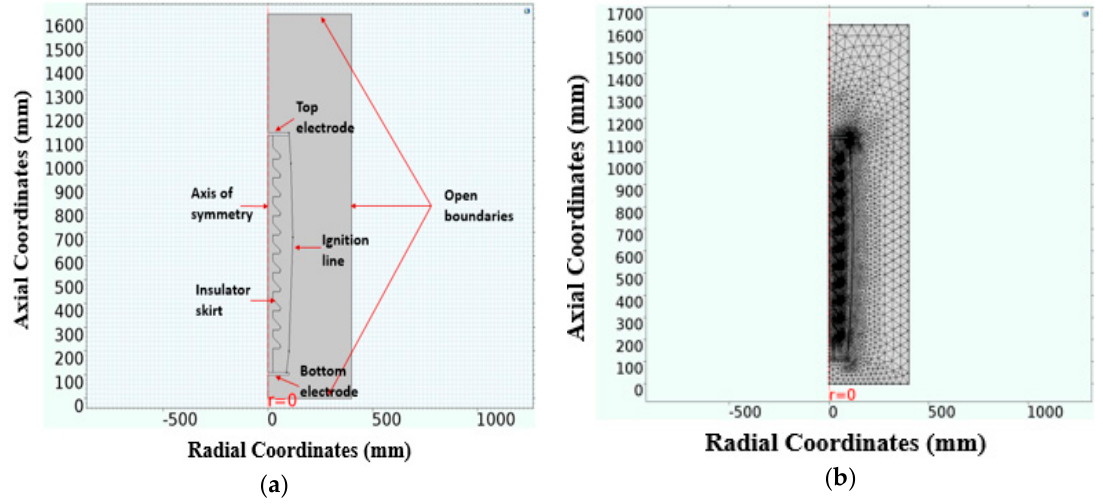
Figure 2. The geometric model and meshing result of the secondary arc simulation: ( a ) The geometric model; ( b ) meshing result. model; ( b ) meshing